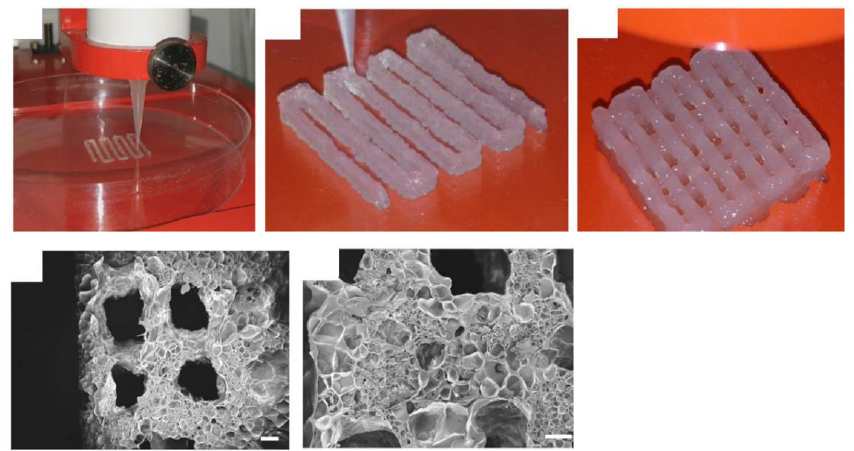
Figure 7. Silk fibroin (SF)-based scaffolds. Extrusion bioprinting process of SF + gelatin bio-ink, obtaining porous scaffolds. Scale bar = 200 µm. Adapted from [64].